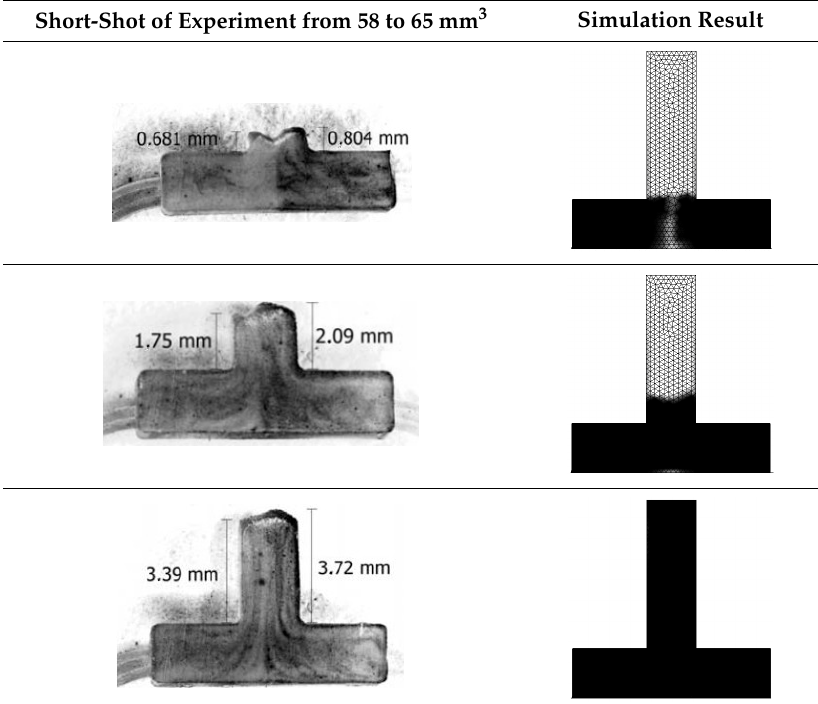
Table 1. Comparison between results from experiment and the improved simulation.